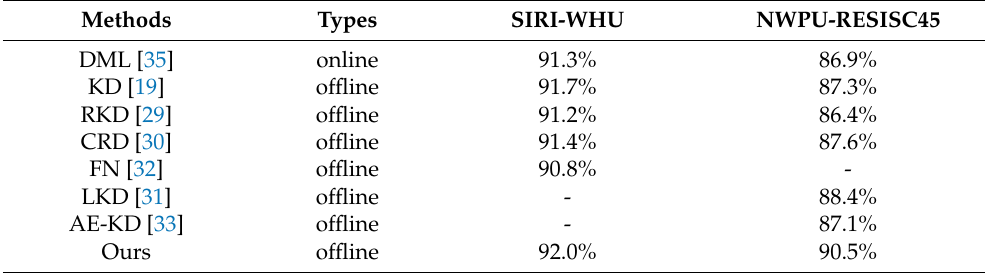
Table 2. The accuracy of ResNet20 while using different knowledge distillation approaches on SIRI-WHU and NWPU-RESISC45.